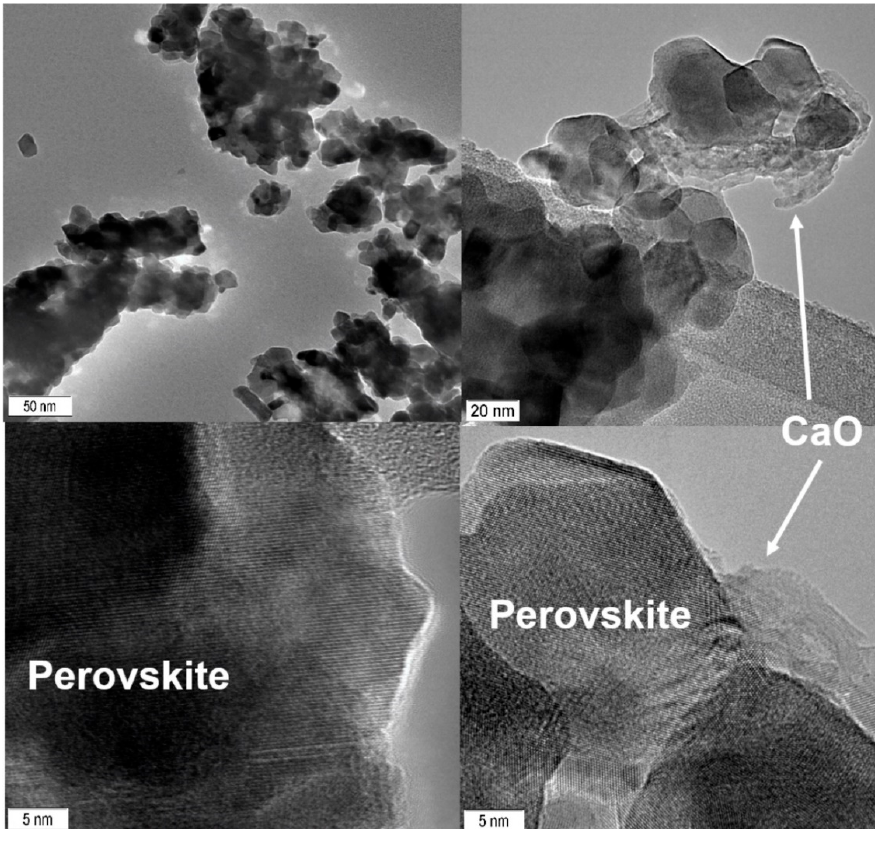
Figure 3. HRTEM images of the sample before and after the reaction.